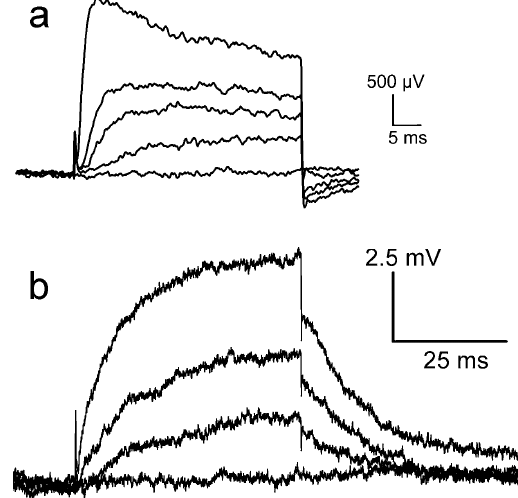
Figure 6. Transistor recordings of the potassium channel Kv1.3 in HEK293 cell at a constant intracellular voltage with an extracellular K concentration of 5 mM . The apparent change of the gate voltage δ V EOS is plotted versus time. ( a ) Gate oxide cleaned with an acidic detergent: depolarizations to − 25, − 15, − 5, and +40 mV starting near the reversal voltage of potassium, repolarization after 40 ms [35]. ( b ) Gate oxide cleaned with an alkaline detergent: depolarizations to − 20, 0, and +50 mV , repolarization after 50 ms (by permission of Springer [13]). The conditions of the experiments differ with respect to channel expression, cell size, and transistor quality. A comparison can refer only to the dynamics and the relative amplitudes of the fast and slow components.